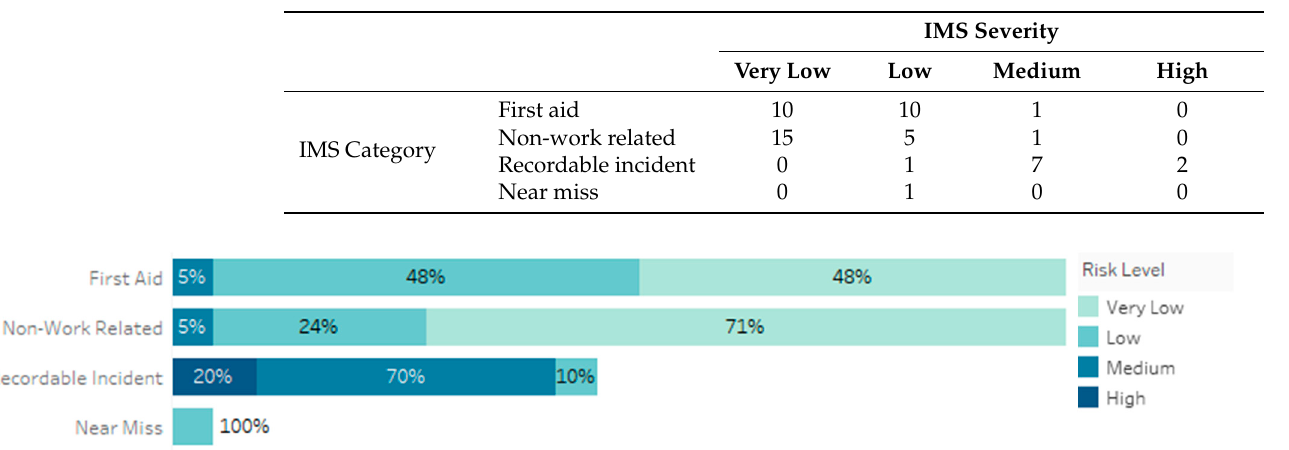
Table 4. Contingency table of IMS categories and severity classifications.